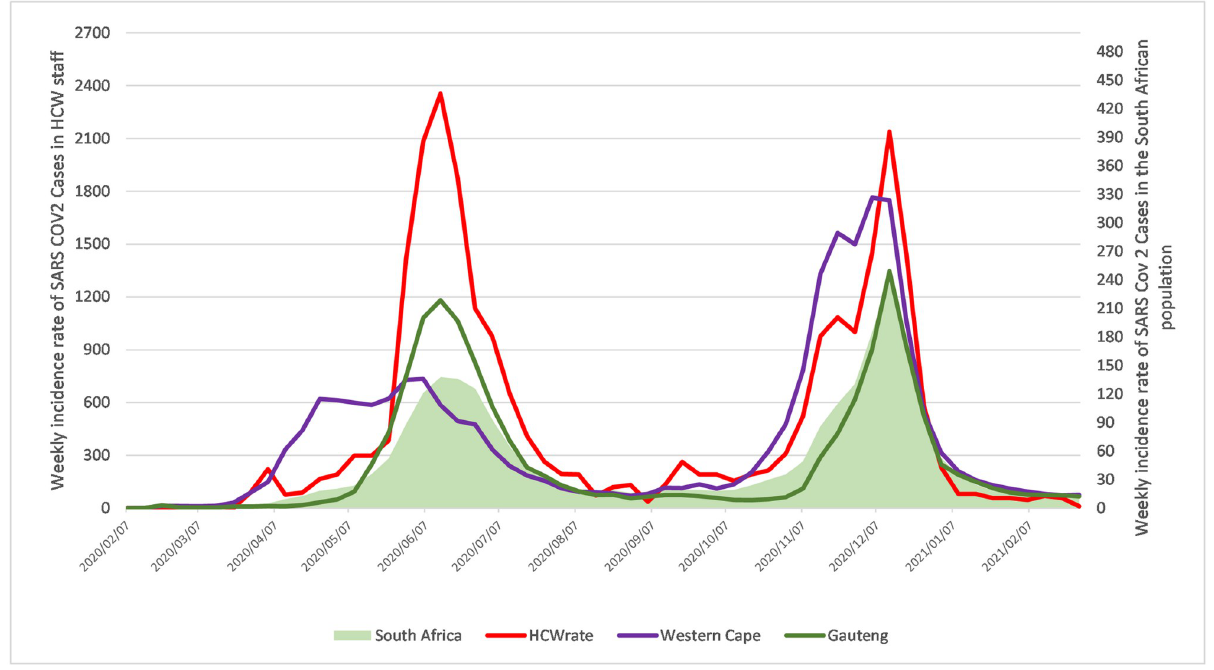
Fig 1. An epidemic curve of the incidence of COVID-19 cases within medical laboratory services staff compared to the general South African population. Weekly incidence rates of PCR confirmed cases of SARS CoV-2 by epidemic week for the South African population (green shading, right axis), medical laboratory services staff (red line, left axis), Gauteng province population (green line, right axis), and the Western Cape province population (blue line, right axis). 1 April 2020–31 March 2021.